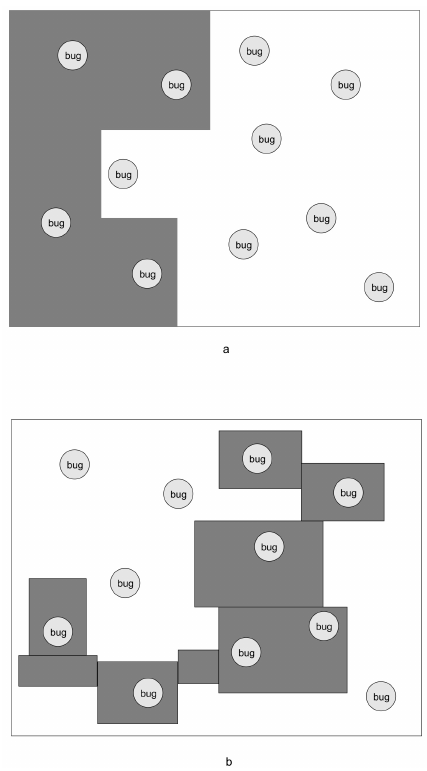
Figure 1. Pure dynamic symbolic execution vs. our approach. Here ( a ) shows the dynamic symbolic execution search will exhaustively explore continuous parts of the state space, and ( b ) shows our approach will search those sub-spaces where the possibility of hidden bugs highly relies on statistic